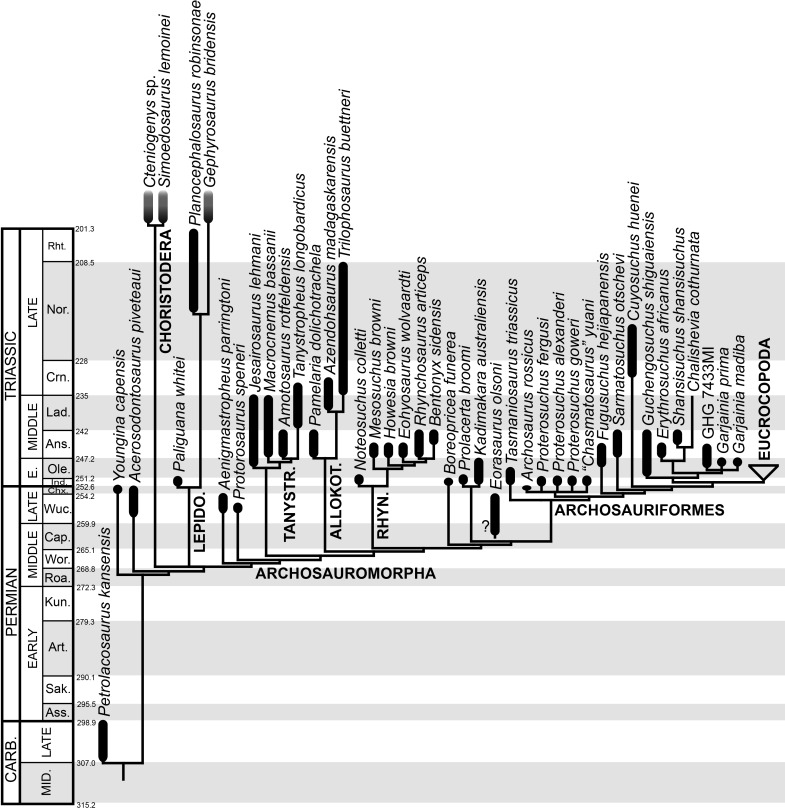
Time-calibrated phylogenetic tree of non-eucrocopodan archosauromorphs recovered in this analysis.Eucrocopodans have been merged into a single terminal in this tree. The length of the vertical bar representing each terminal taxon represents chronostratigraphical uncertainty rather than true stratigraphical range. Abbreviations: Ans, Anisian; Cap, Capitanian; Chx, Changhsingian; Crn, Carnian; E., Early; Ind, Induan; Lad, Ladinian; Nor, Norian; Ole, Olenekian; Rht, Rhaetian; Roa, Roadian; Wor, Wordian; Wuc, Wuchiapingian. Geological timescale after Gradstein et al. (2012).